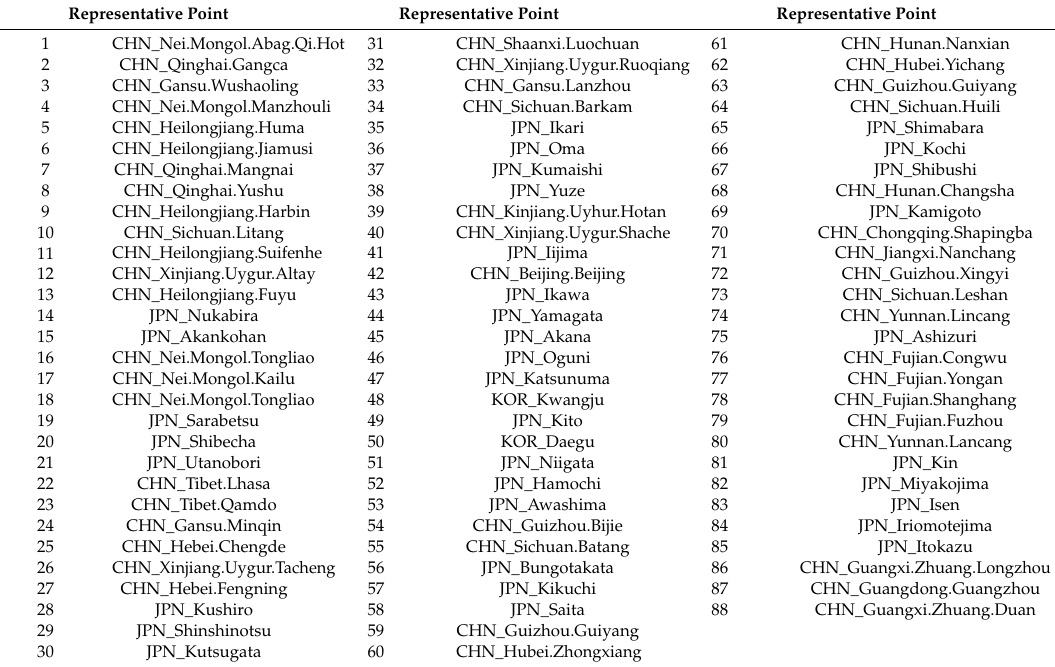
Table 16. Representative points in the 88 regions of solar thermal climate in East Asia. Representative Point Representative Point Representative